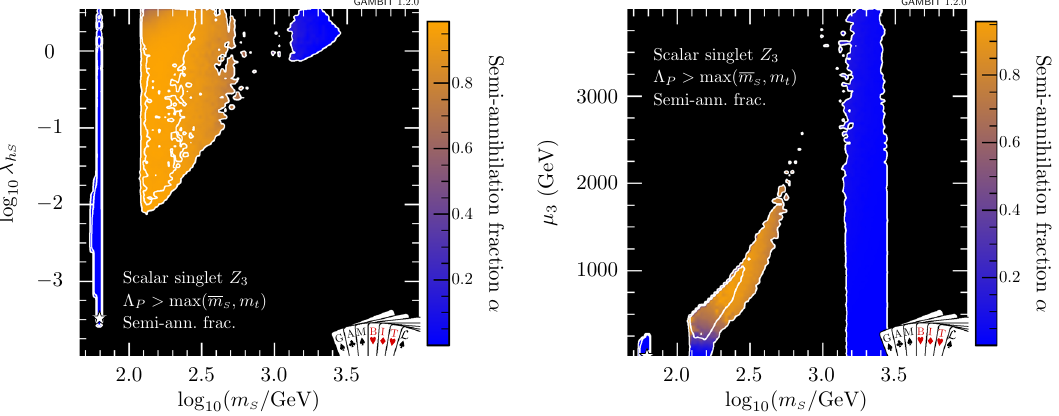
Fig. 9 The semi-annihilation fraction α with respect to λ h S and m S (left) and with respect to μ 3 and m S (right) for the Z 3 scalar singlet model without the requirement of an absolutely stable electroweak vac-